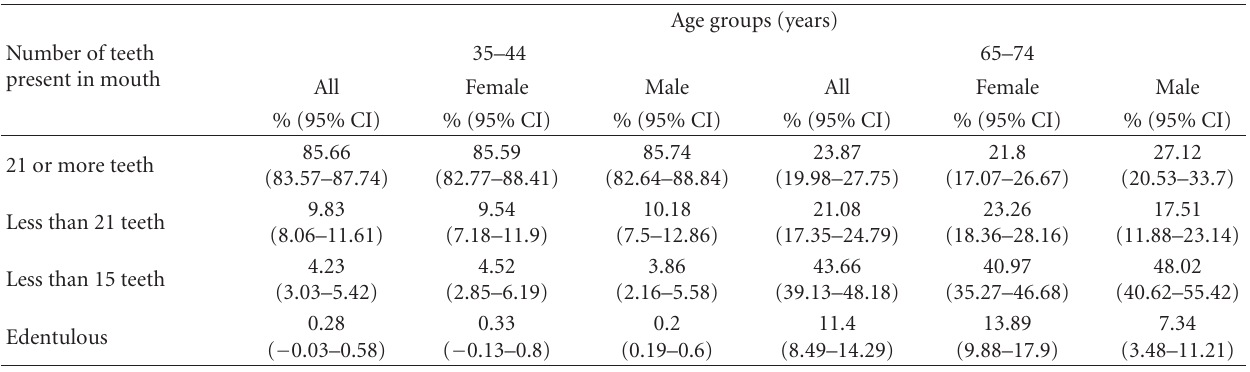
Table 3: Distribution of number of teeth present in di ff erent age groups (% of individuals and 95% confidence interval).